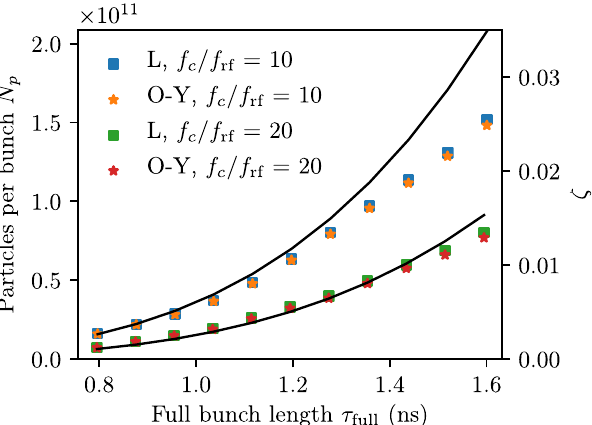
FIG. 4. The LLD intensity threshold in the logarithmic scale as a function of the cutoff frequency of reactive impedance f k f 0 (multiplied by the full bunch length τ ) for two c ¼ max full different values of τ . The analytic predictions from Eq. (50) are full shown by solid lines and the results of semianalytic calculations using MELODY are shown by squares. Parameters are as in Fig. 3. The corresponding intensity parameter ζ is shown on the second vertical axis.